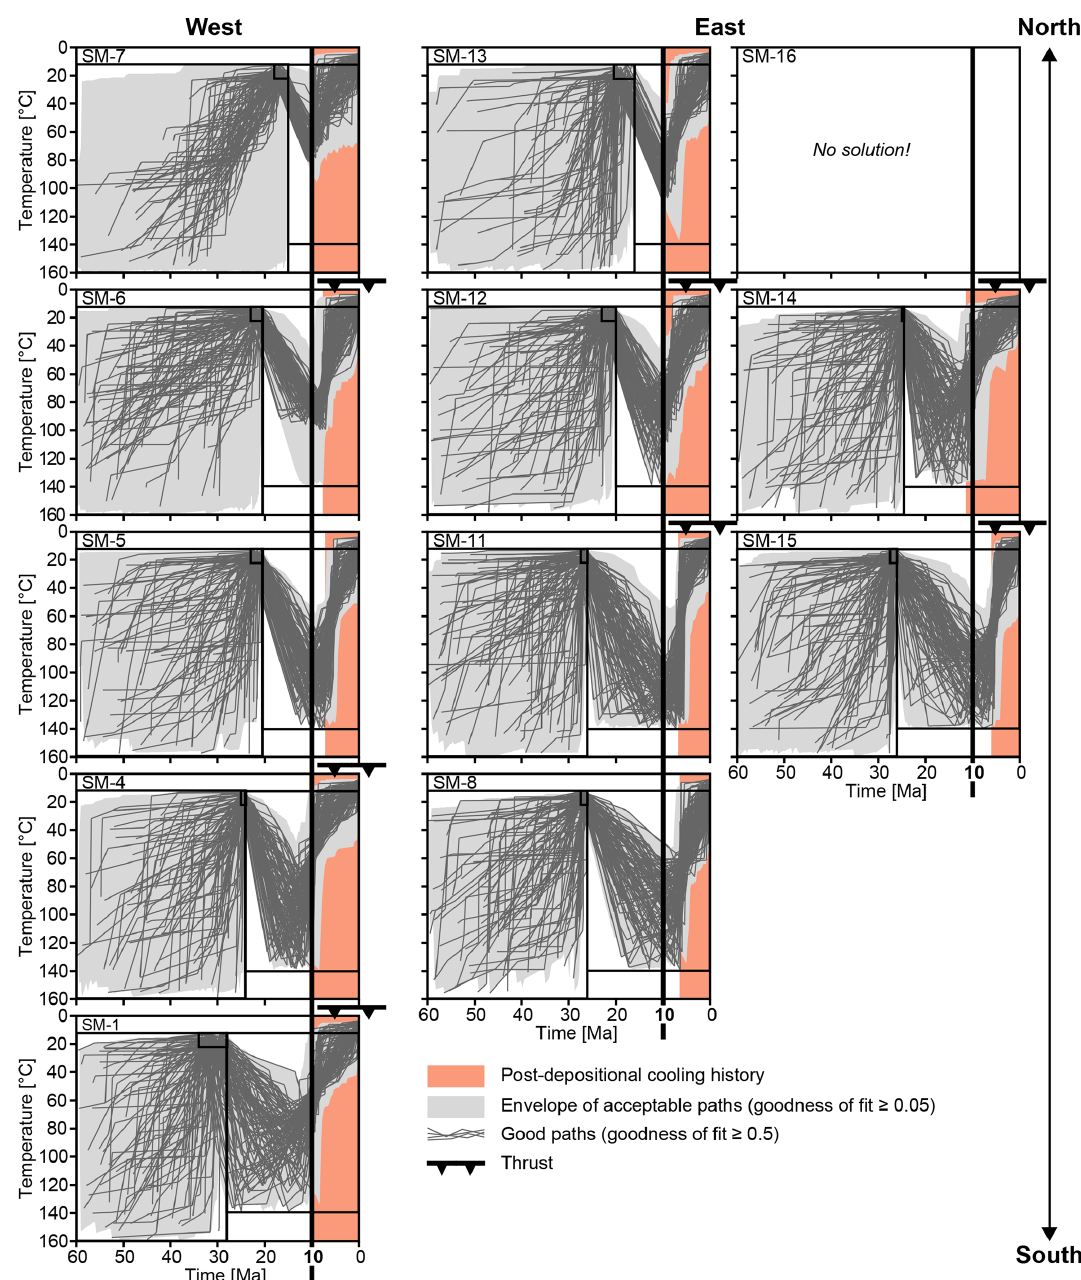
Figure 4. Thermal evolution of samples. The results from inverse modeling of apatite ( U − Th − Sm )/ He (AHe) ages with the HeFTy software (Ketcham, 2005) show the time–temperature history of the samples discussed in the text. Modeling constraints are shown as black boxes. The bold black lines at 10Ma serve as a visual time reference. The thermal histories for the different samples are aligned from north to south and from east to west according to their sample